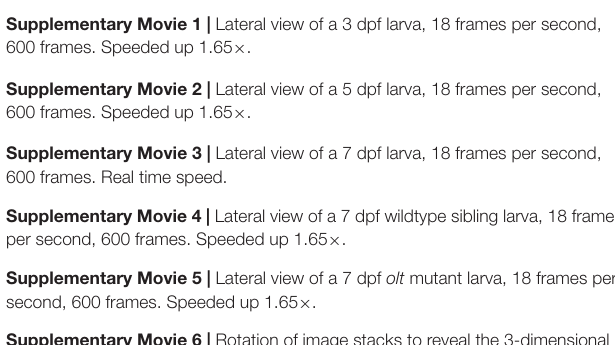
Supplementary Figure 5 | Measurement of motor axon lengths and branch numbers. Flowchart of axon imaging and analysis using Tg (zCREST1:mRFP) larvae. Confocal image stacks were 3D rendered, allowed for manual tracing of trigeminal axon and FBMN axons. The tracing and measurement processes were performed in LAS-X using the “polygon” tool, starting at the hindbrain exit points for both motor axon fascicles. At every step of tracing axons and branches, the 3D images were rotated and viewed at different angles, and the polygon tool was adjusted to ensure that it was on the surface of the axon. Data were exported and traced images were saved as configuration in 3D. Supplementary Figure 6 | Axon fascicles on ih muscle are more numerous and thinner in olt mutants. (A,B) Ventral view with anterior to the left of the jaw musculature in 5 dpf Tg(zCREST1:mRFP);Tg( α -actin:GFP) larvae showing motor axons (red) and jaw and gill muscles (green). The numbered lines 1–6 indicate the positions of the virtual sections along the left and right ih muscles where the red fluorescence intensities corresponding to axon fascicles were plotted to count fascicles and measure their thickness. (C) The number of axon fascicles was significantly higher in olt mutants. (F) The axon fascicles were significantly thinner in olt mutants. Supplementary Figure 7 | Facial branchiomotor neurons are less active in olt mutants. Re-analysis of FBM neuron activity in a subset of samples that were used for analysis of activity in trigeminal motor neurons in Figure 7 . (A,B) Representative GCaMP6s (cid:49) F / F traces for two wildtype (A) and two olt mutant (B) larvae. Due to the broad peaks, thresholding-based event counting was not used. Instead, Ca 2 + events (asterisks) were manually identified by two observers independently by viewing the recordings. (C) The frequency of Ca 2 + events in FBM neurons was significantly lower in olt mutants compared to wildtype siblings as seen in Figure 7 . Number of larvae in